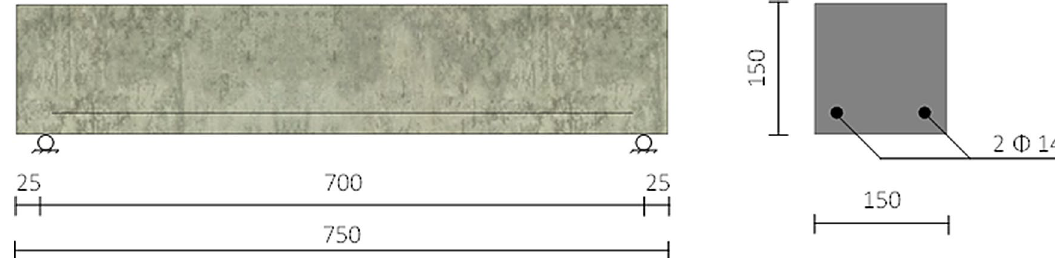
Fig. 1 RC beam without stirrups (All dimensions in mm)